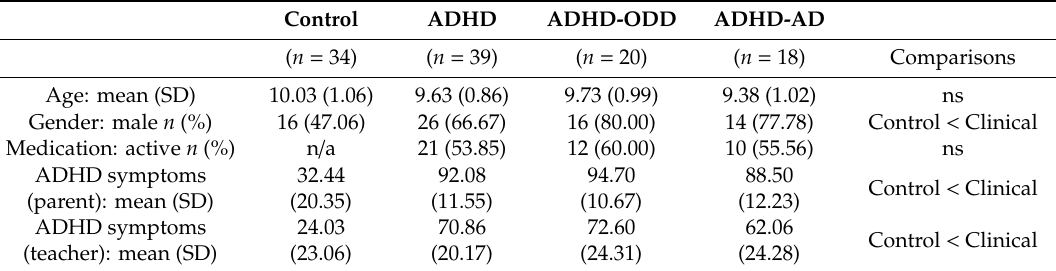
Table 1. Participant demographics by